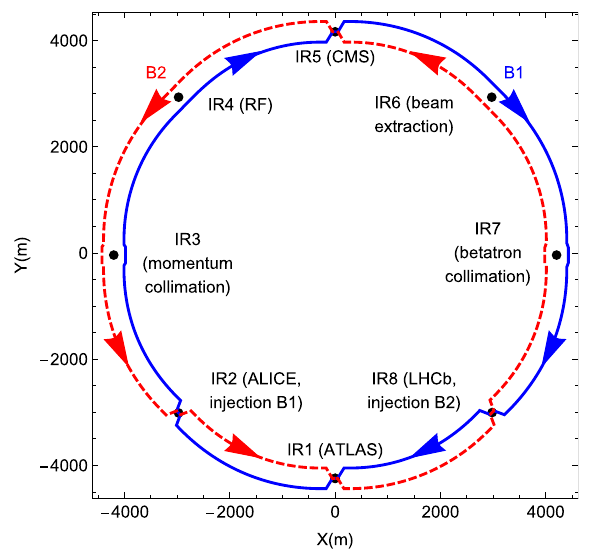
FIG. 1. The schematic layout of the LHC showing the eight insertions of which four house experiments. Of particular importance for this study is the betatron cleaning in IR7. The two counterrotating beams are shown schematically, i.e. their actual separation of 194 mm in the arcs is not to scale. This figure was adapted from Ref.